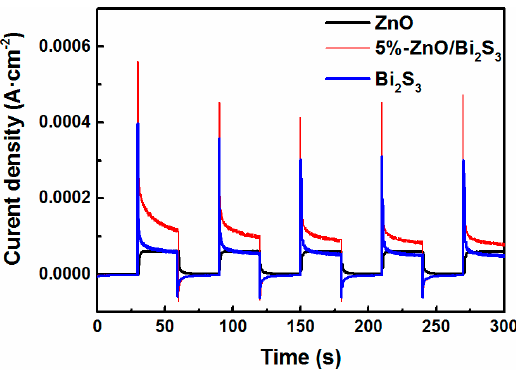
Figure 6. Transient photocurrent responses of ZnO, Bi 2 S 3 and 5%-ZnO/Bi 2 S 3 composite under visible light exposure.